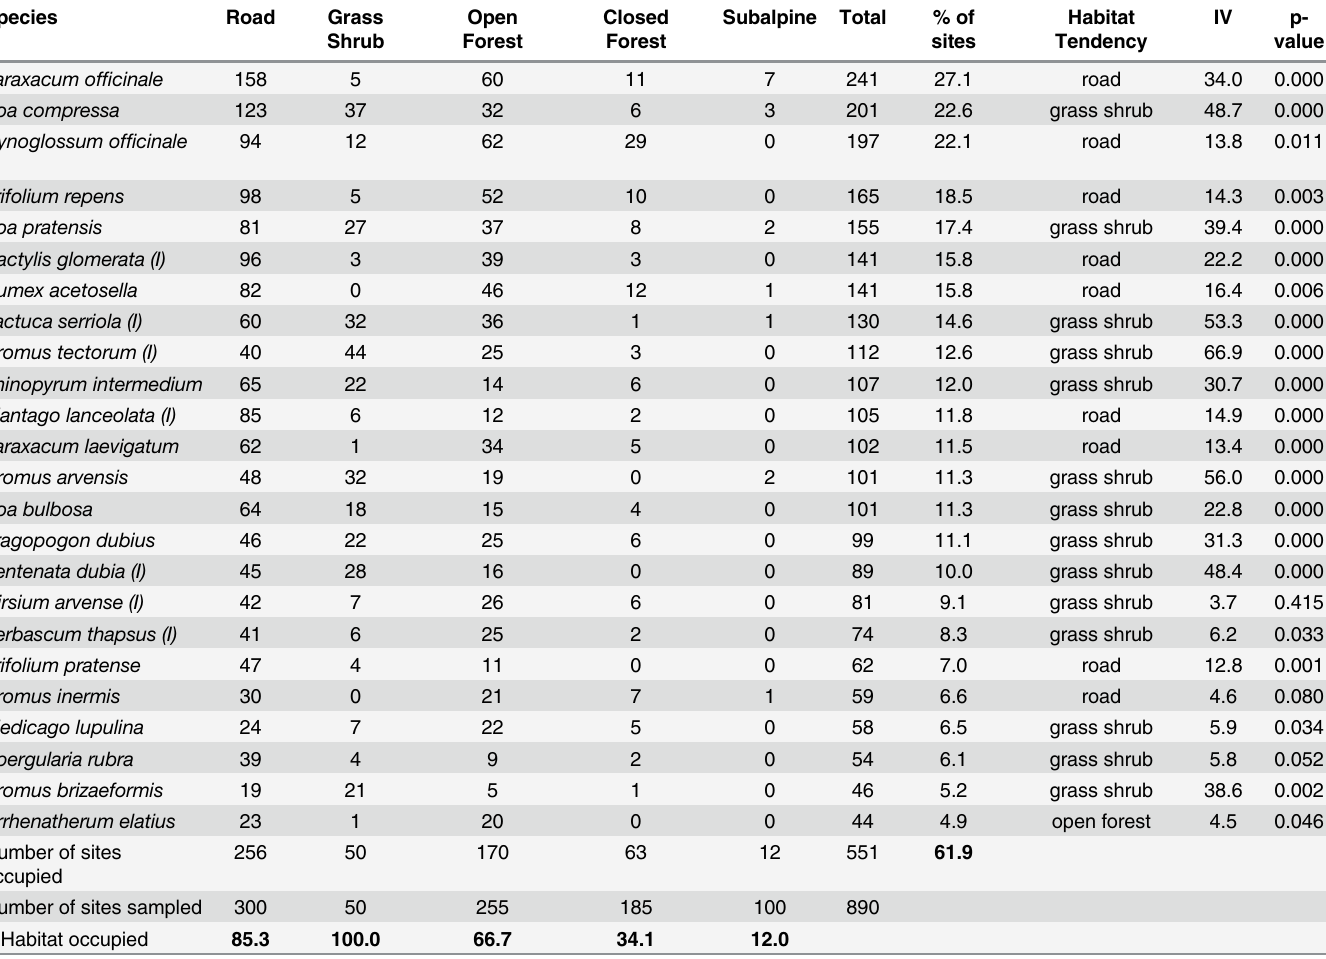
Table 1. Frequency of occurrence by habitat type for non-native plant species. Species indicator values (IV) are reported along with specific habitat tendencies and statistical significance for each